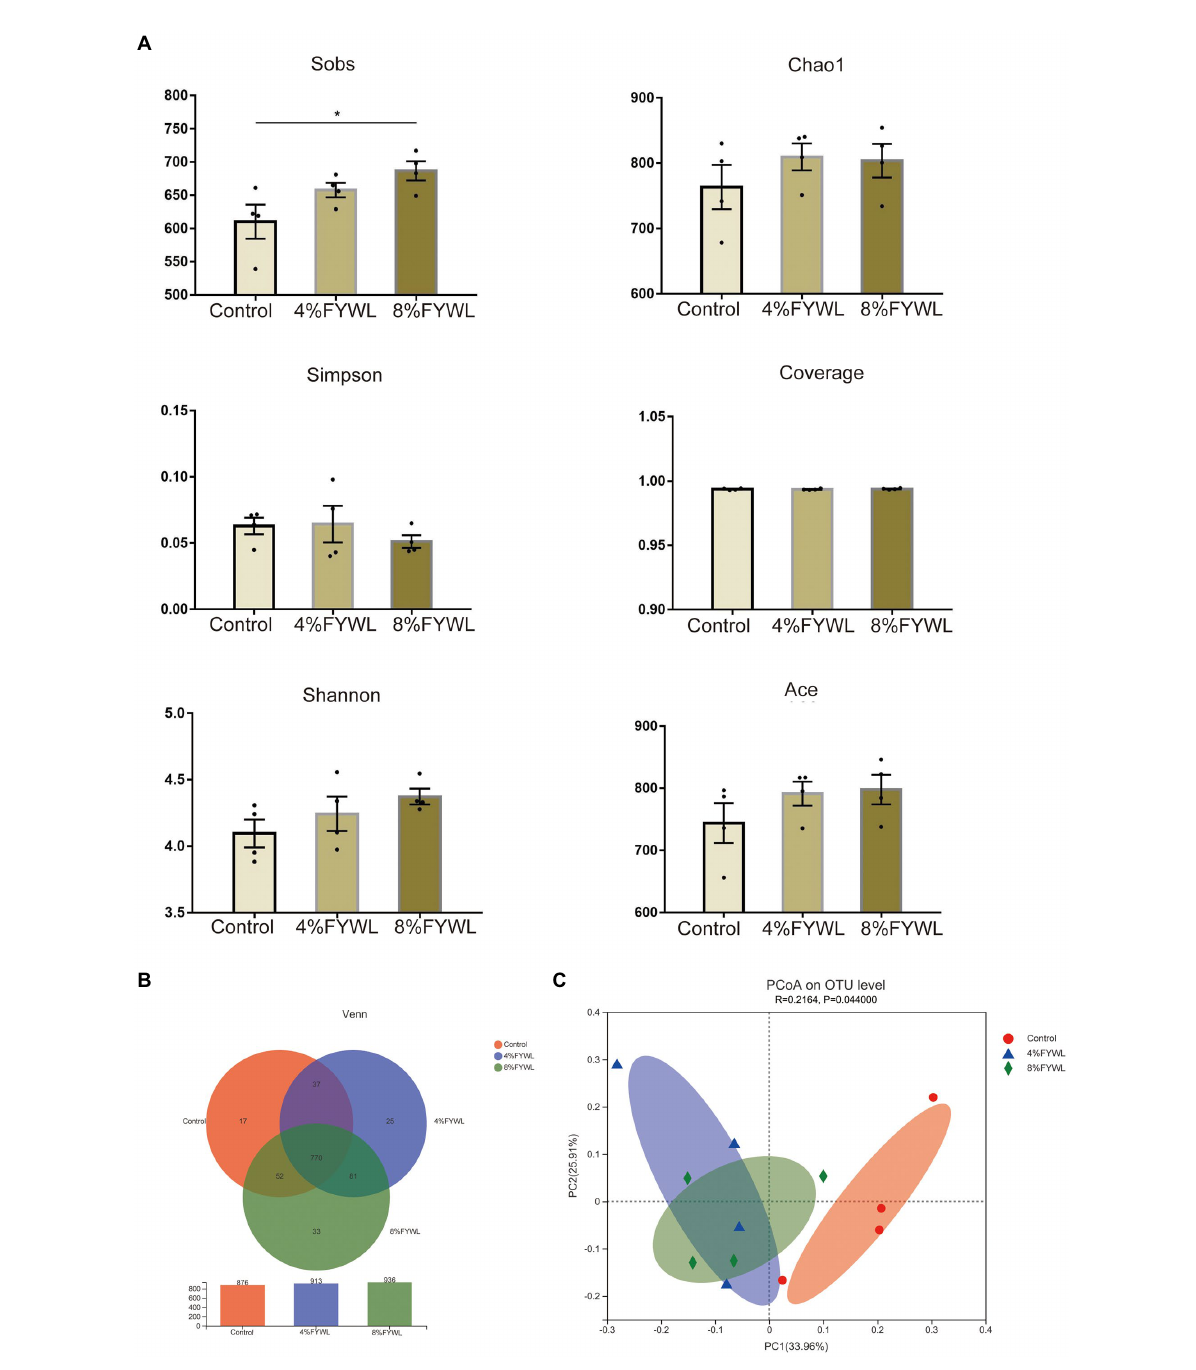
FIGURE 2 Diversity and composition of microbiota in different groups. (A) Column of α diversity indices of bacterial community based on 16S rRNA sequencing. (B) Venn diagram. (C) Principal co-ordinates (PCoA)